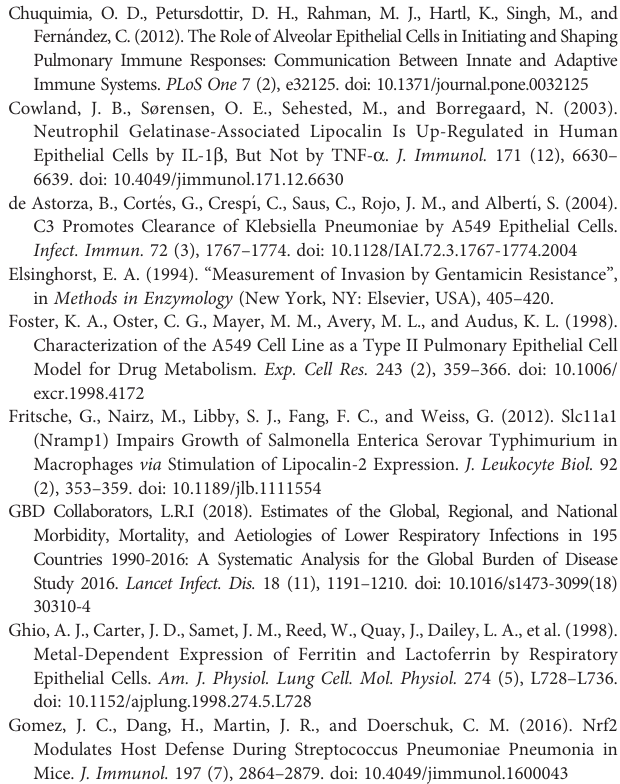
Supplementary Figure 5 | Differential mRNA expression of NRF2-associated genes FPN (A) , HO1 (B) , FTH (C) , FTL (D) . and KEAP1 (E) in infected A549 cells, treated with ROS-scavenger NAC. A549 cells were infected for 2h with E. coli or K. pneumoniae at MOI of 10, subsequently washed thoroughly and harvested after 6h of intracellular infection. Cells were treated with 5mM NAC 20 min before infection, and during intracellular infection. Data (n=3) shown as mean ± SEM, normalized to corresponding solvent controls ROS, reactive oxygen species; NAC, N-acetyl- cysteine; K. pneu ., K. pneumoniae ; NRF2, NF-E2-related factor 2; FPN , ferroportin; HO1, Heme oxygenase-1; FTH, ferritin heavy chain; FTL, ferritin light chain; KEAP1, Kelch-like ECH-associated protein 1.